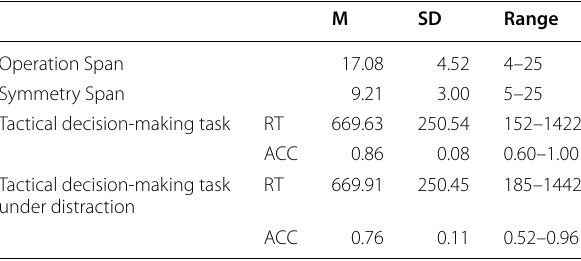
RT response time, ACC accuracy